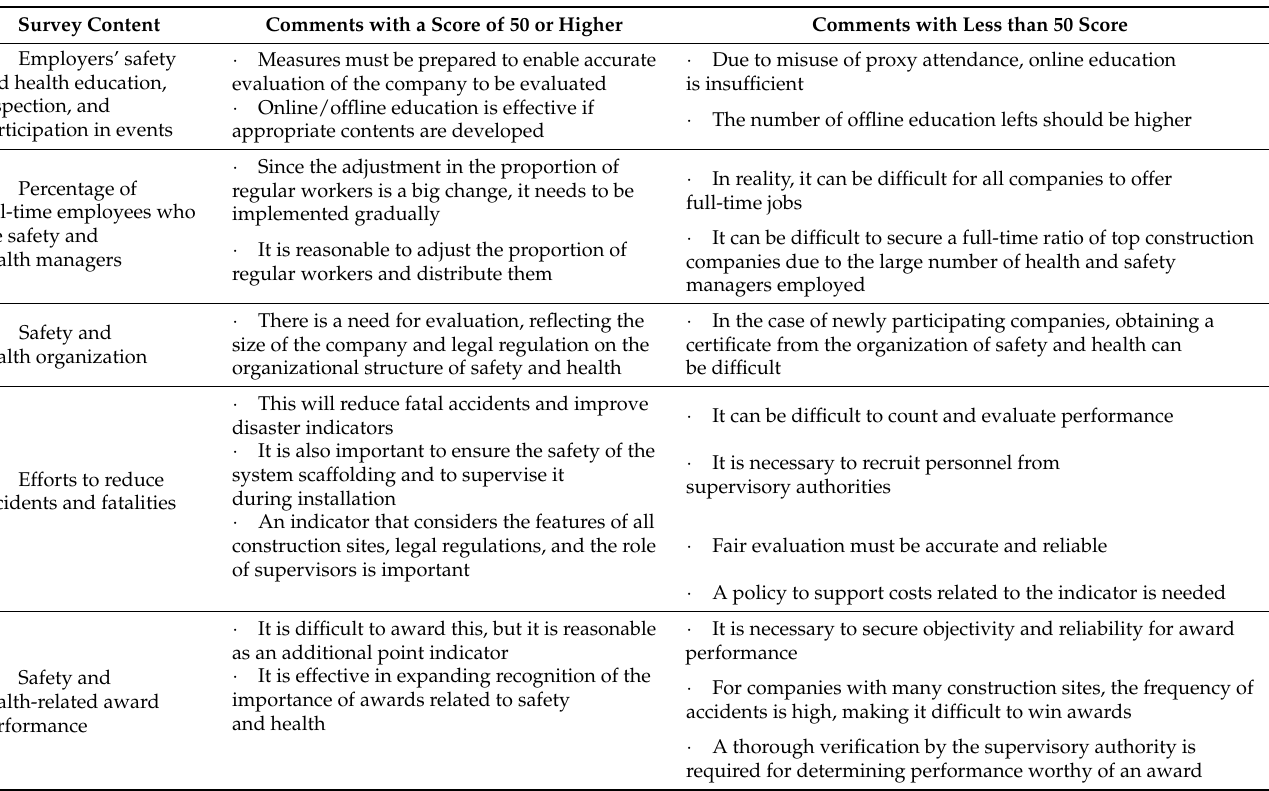
Table 18. Additional comments on each item of the improvement